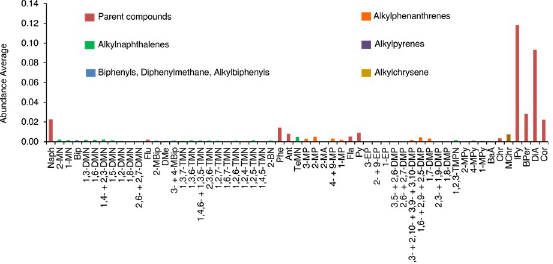
Fig 4. The relative abundance of pyrogenic compounds averaged in all